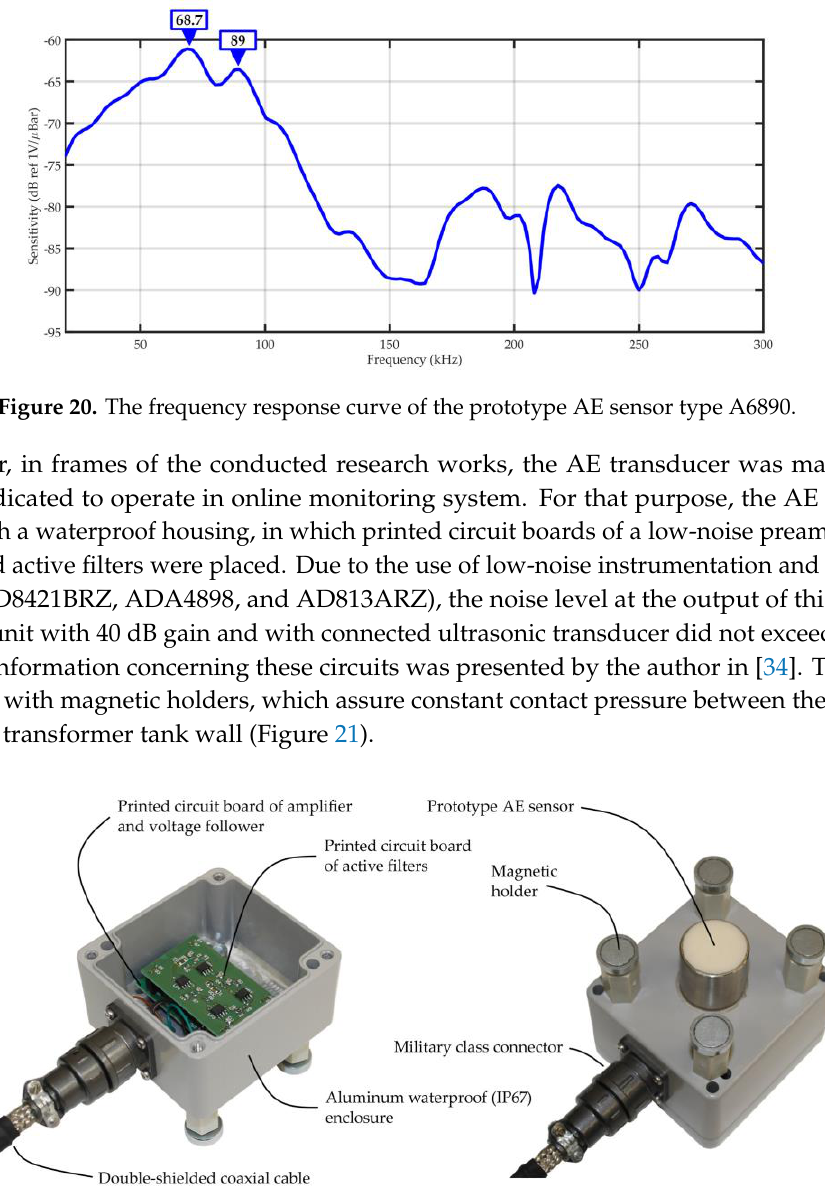
Figure 21. Prototype AE sensor integrated with IP67 waterproof preamplifier housing equipped with magnetic holders.